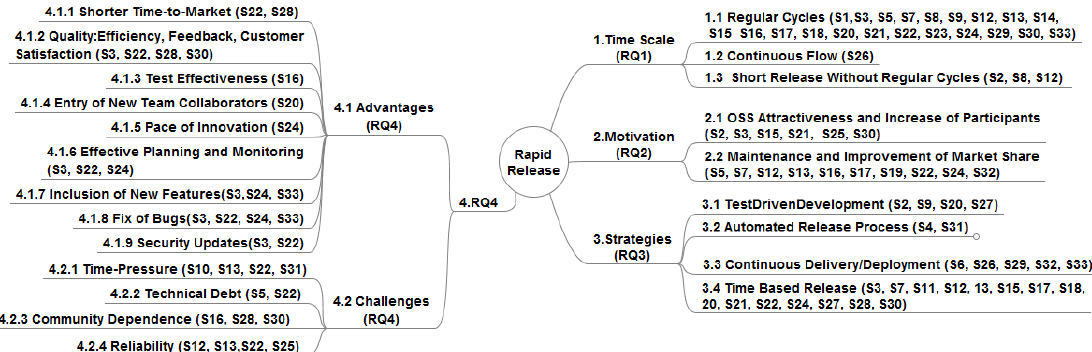
Figure 2. Findings from the selected